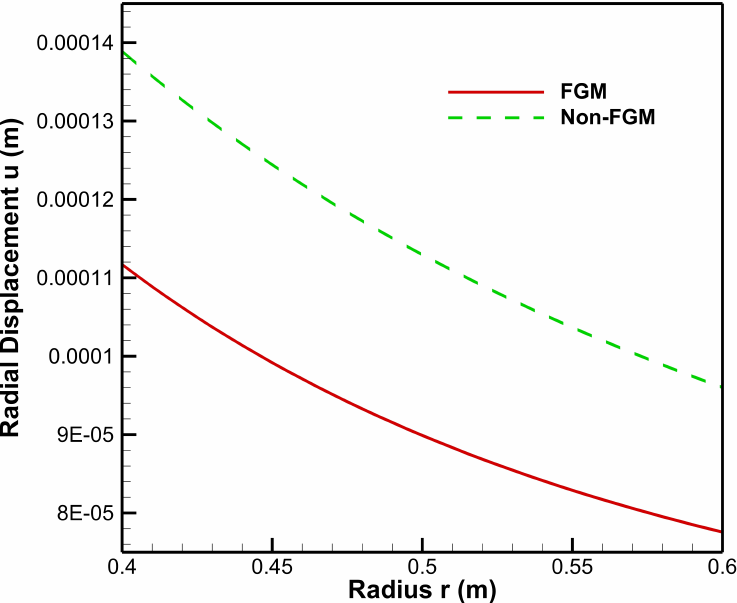
Figure 14. Displacement along the radius of the cylinder under internal pressure, P a = 50 MPa and external pressure, P b = 20